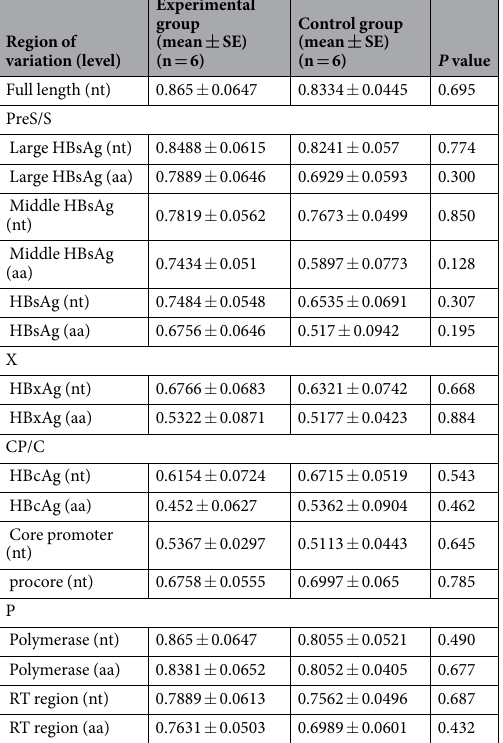
Table 2. Quasispecies complexity (Sn) between the patients with coexisting HBsAg and anti-HBs and